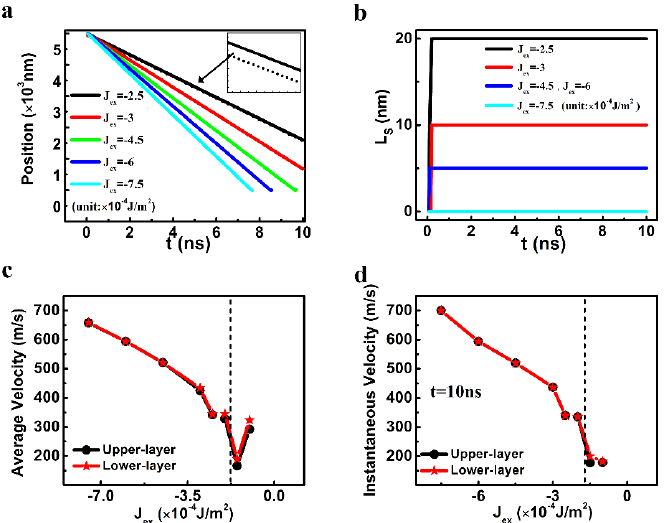
Figure 4. ( a ) The temporal central positions of the DWs in the two layers (The solid and dashed lines represent the results in the upper layer and in the lower one, respectively.), ( b ) the temporal length of the staggered domains of the SAF racetrack, ( c ) the average velocity, and ( d ) the instantaneous velocity of the DW as a function of the interlayer exchange coupling constant. Other parameters of D, K L , K U were fixed as 0.75 mJ/m 2 , 2.5 × 10 5 J/m 3 , and 6 × 10 5 J/m 3 , respectively.